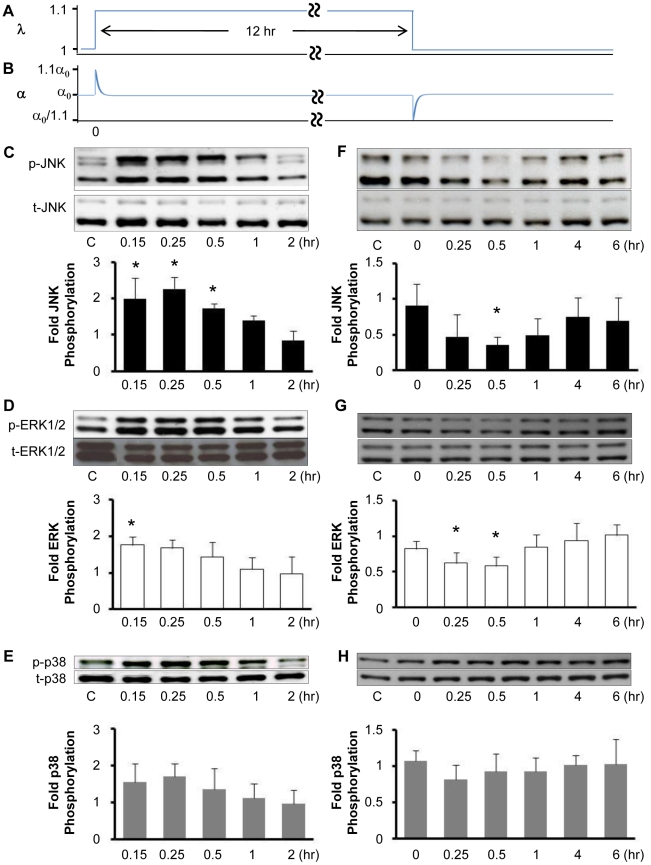
Transient changes in strain rate induce transient changes in the levels of JNK, ERK and p38 phosphorylation.Confluent BAECs were subjected to a stretch release maneuver consisting of 10% equibiaxial stretch λ, followed by the release of the stretch 12 hr later (A), which was predicted to generate a transient increase and subsequent transient decrease in fiber stretch α (B). Representative Western blots of phospho-specific and total JNK (C, F), ERK (D, G) and p38 (E, H) from cell lysates collected at the indicated times after the initial stretch (C–E) and subsequent stretch release (F–H). Optical density measurements were quantified to determine relative amounts of phosphorylated MAPK normalized by the respective total MAPK. The values (means±S.D.; n = 4) indicate the fold change in phosphorylation relative to static controls for each individual experiment. * indicates significant difference from static control (P<0.05).